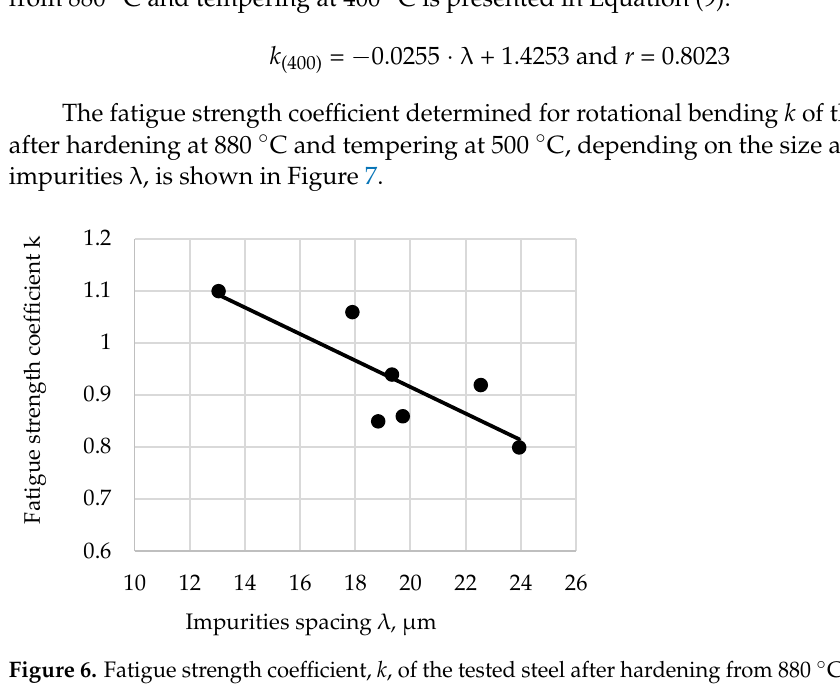
Figure 6. Fatigue strength coefficient, k , of the tested steel after hardening from 880 ◦ C and tempering at 400 ◦ C depends on impurities spacing λ .